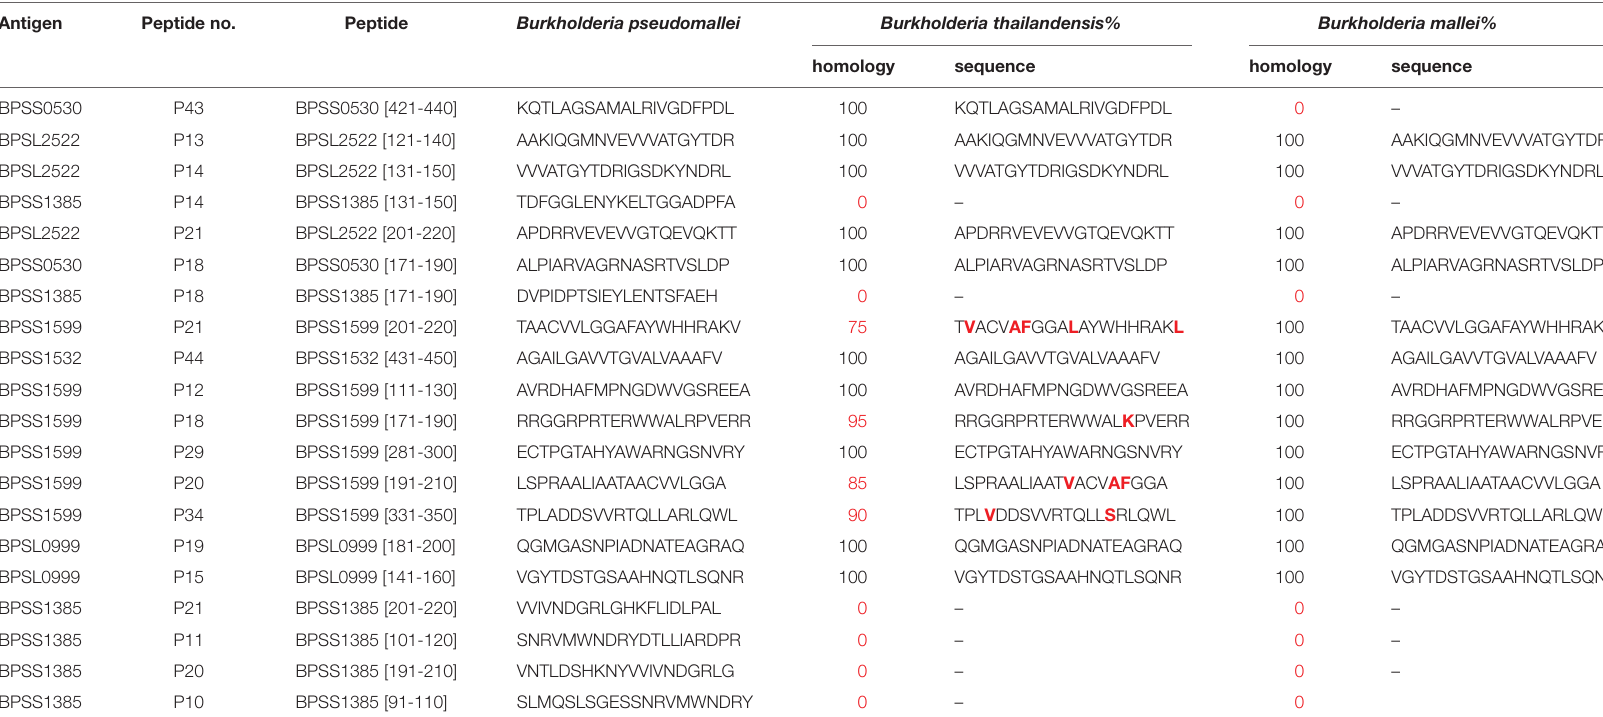
TaBle 4 | Sequence homology between Burkholderia pseudomallei (Bp), Burkholderia thailandensi s (Bt), and Burkholderia mallei (Bm) for the twenty most commonly recognized Bp epitopes. antigen Peptide